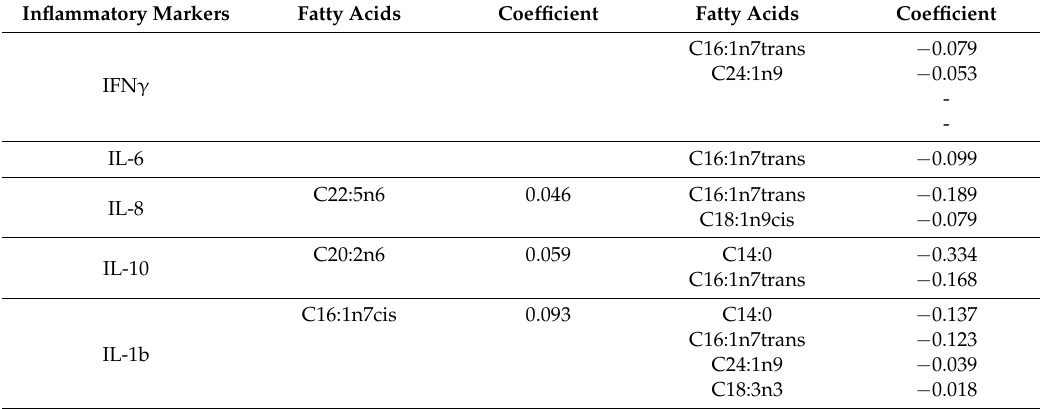
Table 4. Fatty acids ranked from the highest to the lowest elastic net positive or negative regression coefficients for inflammatory markers at 1 year ( n =